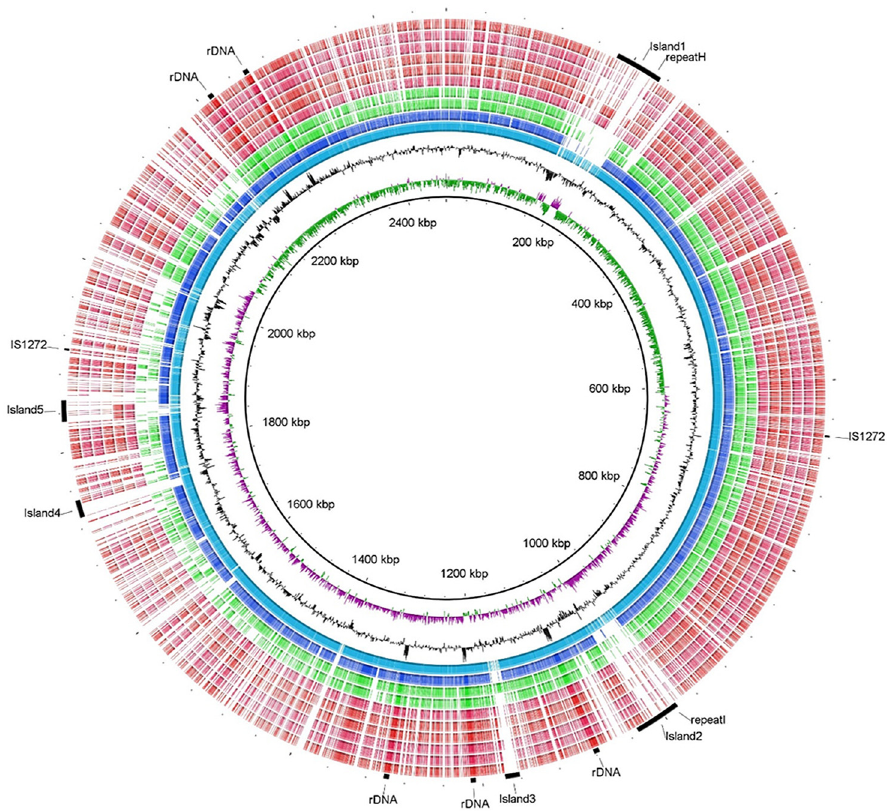
Fig 2. BLAST Ring Image comparing Staphylococcus genomes. BLAST Ring Image Generator version 0.95 [35] was used to analyse the S . agnetis 908 2.4 Mb contig by position (inner ring 1), GC skew (ring 2), and for GC content (ring 3). BLASTn conservation (minimum threshold 50%) in other Staphylococcus genomes proceed outward S . agnetis CBRMN20813338, S . hyicus ATCC11249, S . pseudintermedius HKU10-03, S saprophyticus ATCC15305, and then five S . aureus genomes for strains FPR3757, TW20, ST228, N315, JH1, and 04 – 02981. The outer ring indicates features described in the text for the S . agnetis 908